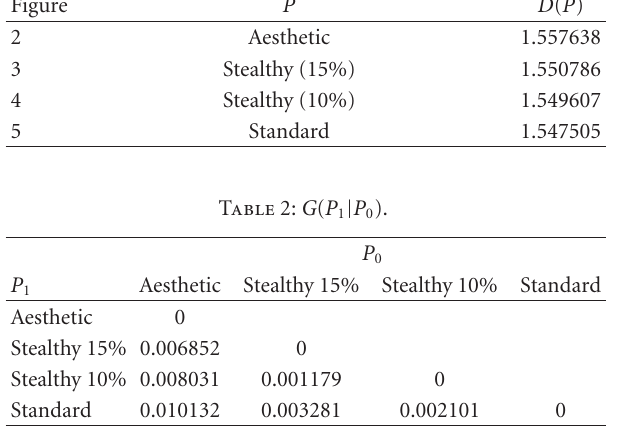
Table 1: Fractal dimensions, D ( P ), for each path, P , of trial 18. Figure P D ( P )